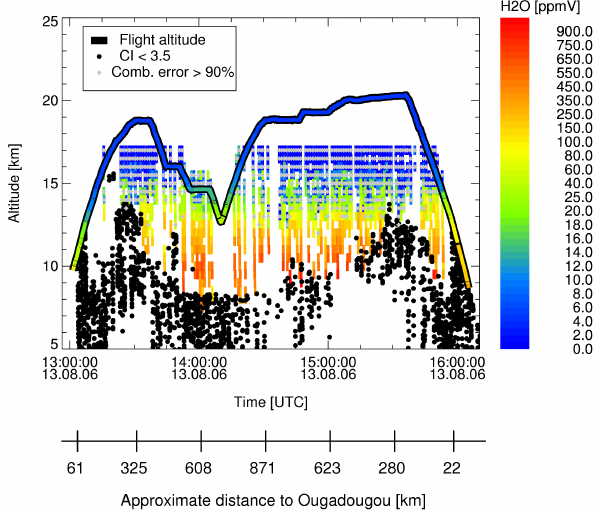
Fig. 9. CRISTA-NF and FISH H 2 O during flight L5. The FISH H 2 O are plotted along the flight altitude with the same color scale as the 2-D representation of CRISTA-NF H 2 O. Black dots mark spectra with a CI lower than 3.5. Note the non-linear color scale.